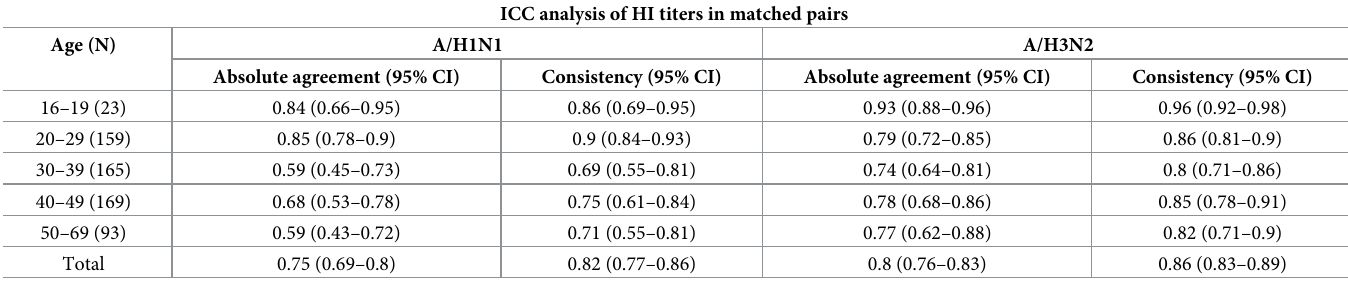
95% CI, 95% confidence